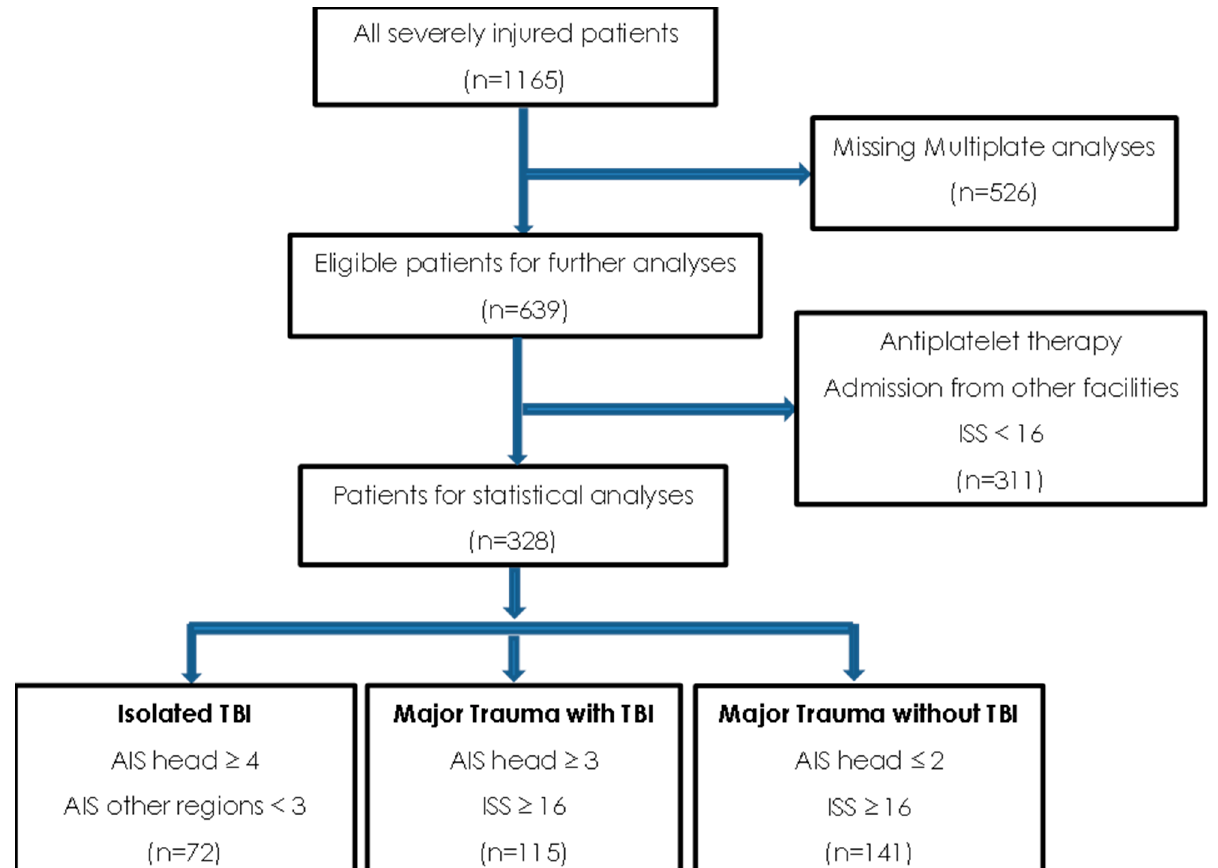
Figure 1. Included and excluded patients with multiplate test results upon emergency room admission.